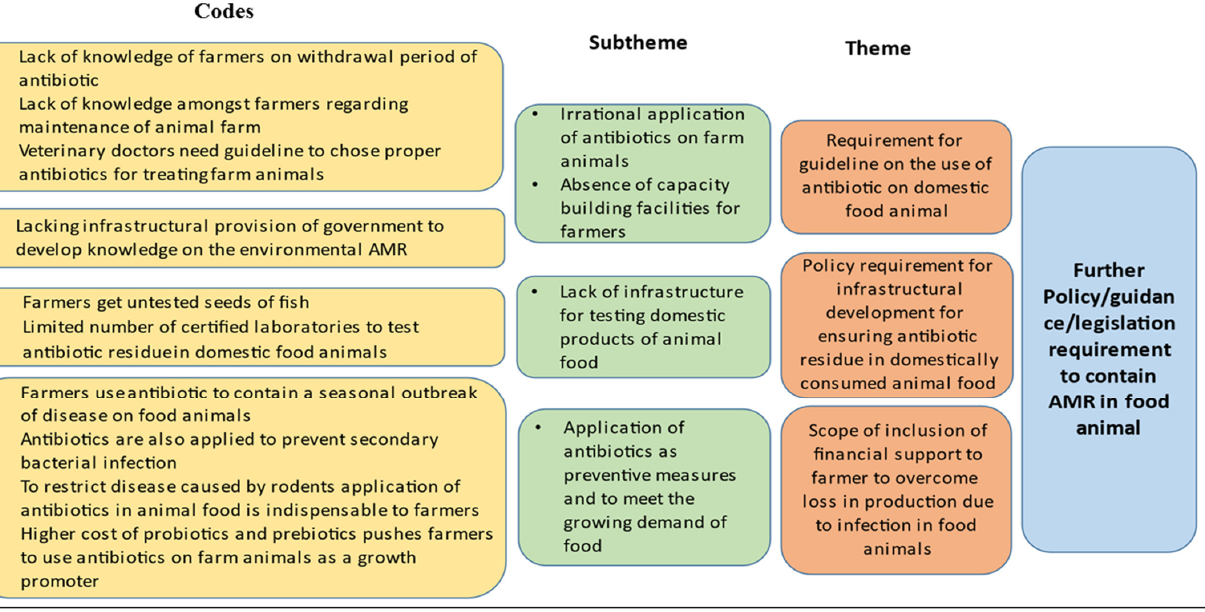
Table 3. Guidelines on the rational use of antibiotics on human beings.